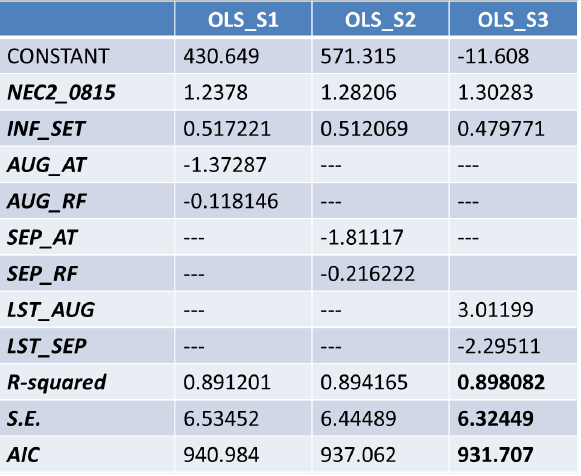
Table 2. OLS models for September 2015 considering previous month’s weather conditions.